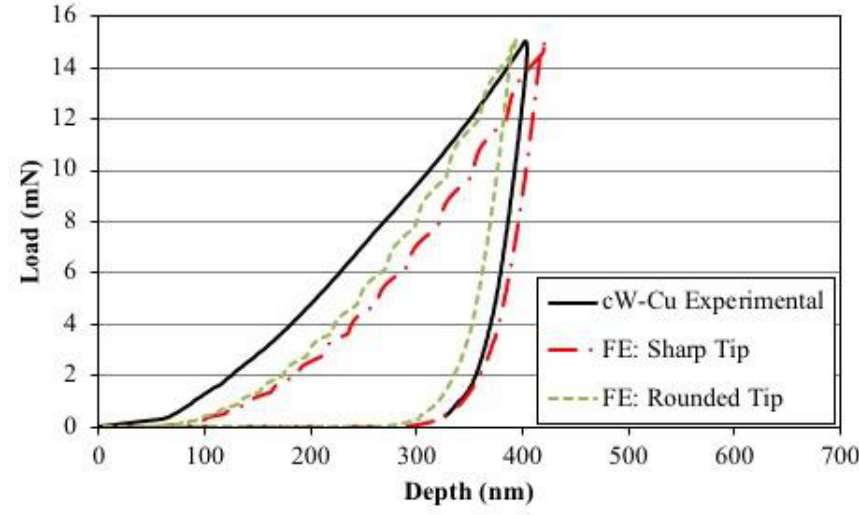
Figure 9. Comparison of the experimental result of the cW-Cu specimen with the numerical results utilizing sharp and rounded Berkovich indenters.